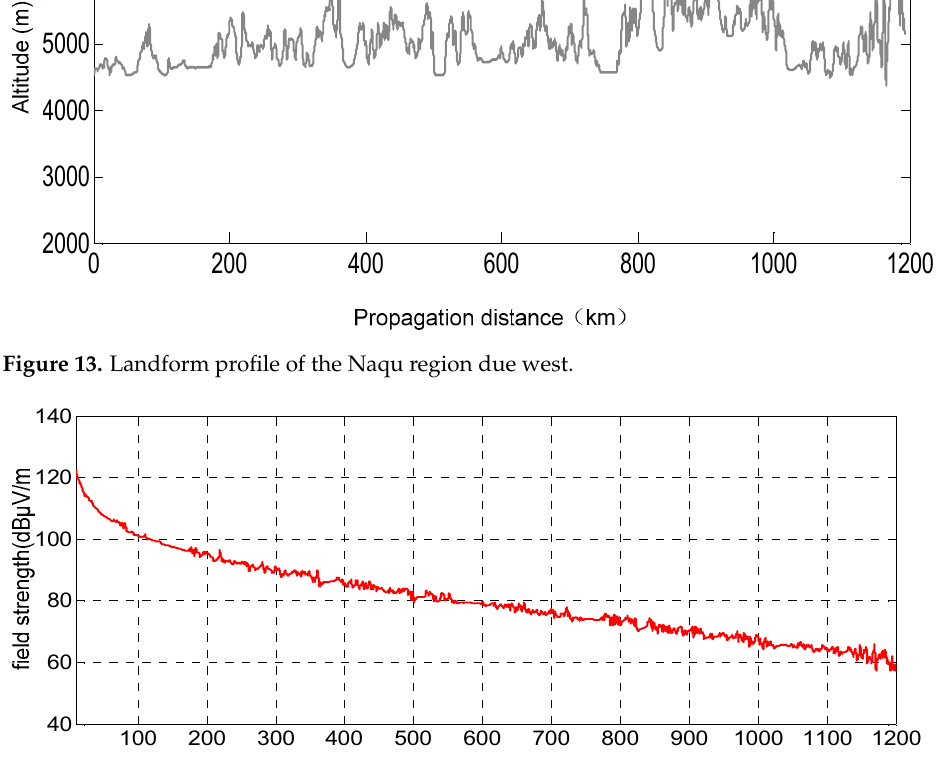
Figure 14. Field intensity propagation curve of the transmitted signal from the westward-oriented antenna.